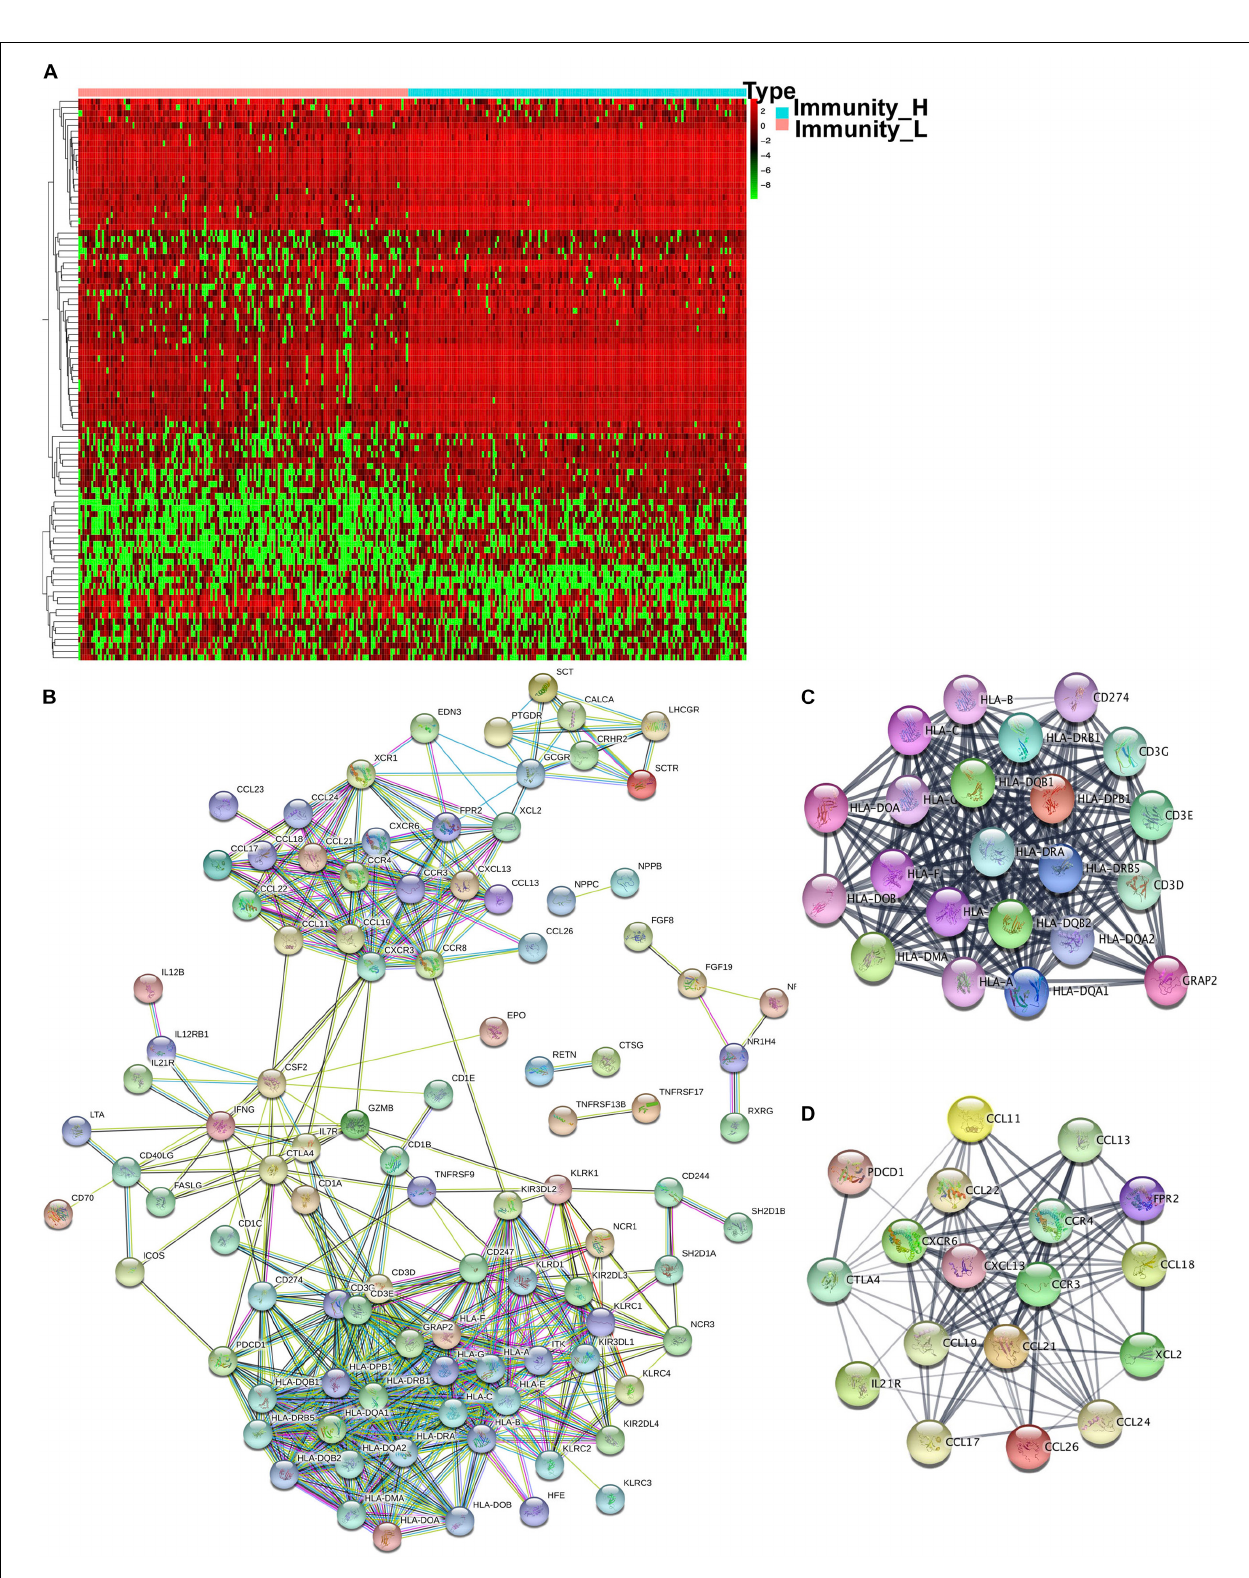
FIGURE 5 | The different expressed immune-related genes and PPI network in OC tissues. (A) The heatmap of OC tissues and the different expressed immune-related genes between the high- and low-abundance immune groups. (B) PPI network of those different expressed immune-related genes. (C,D) Hub modules were analyzed using MCODE (module 1 score = 20.09 and module 2 score =